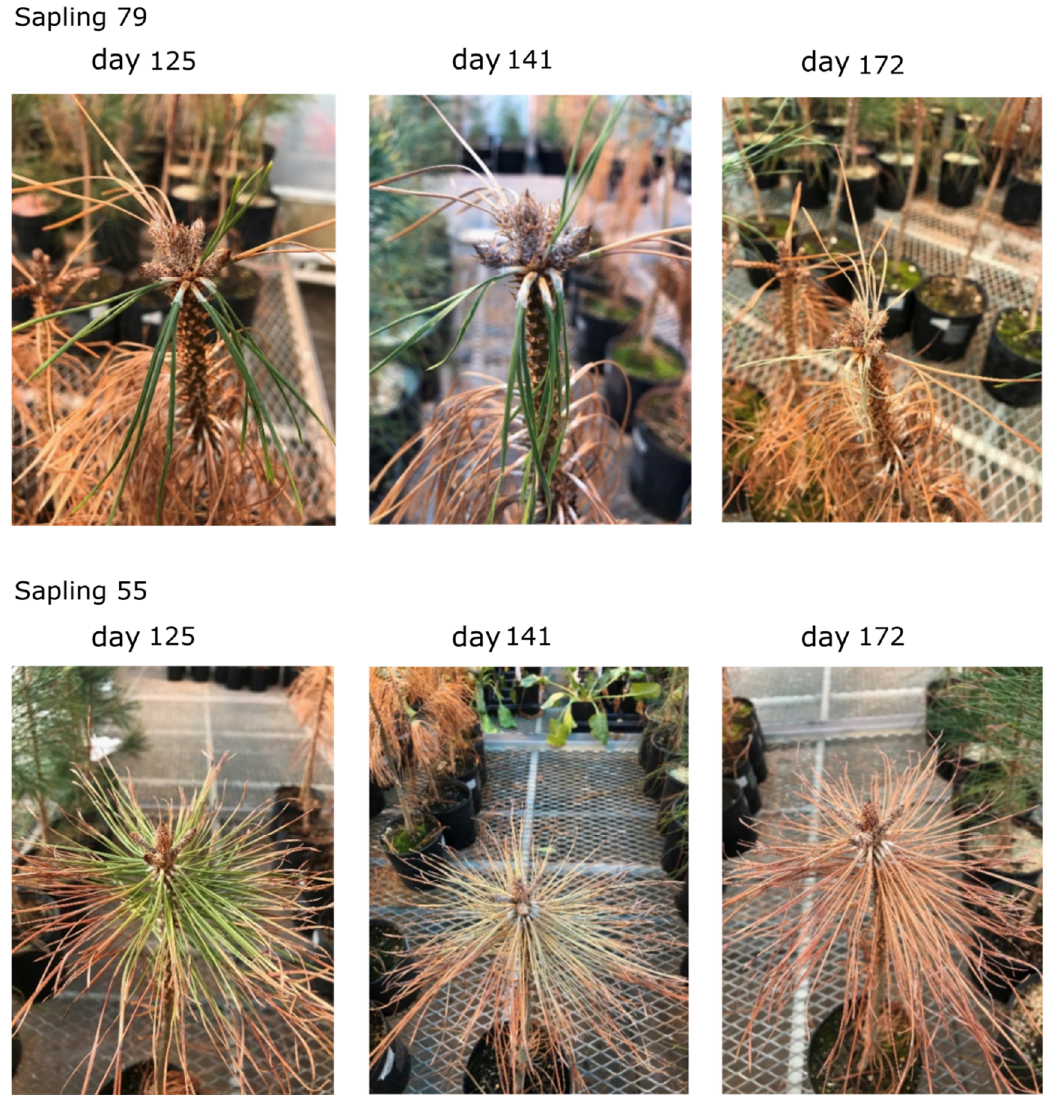
Figure 3. Bud and foliage mortality between 125 and 172 days post-fire for two example Pinus ponderosa saplings burned at 0.7 MJ m −2 . Bud mortality was observed in a well-watered sapling (sapling ID 79) and crown mortality in a drought-stressed sapling (sapling ID 55). Numbers above each panel represent days post-fire.